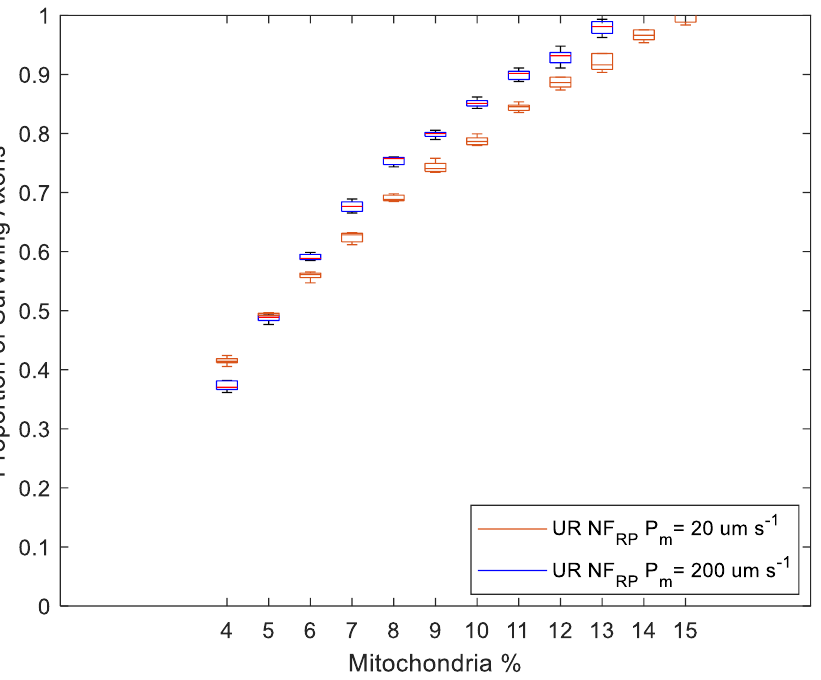
Figure 9. Axonal survival increases proportionally with the mitochondrial volume ratio (mito%) when the H 2 O 2 production rate in the Stress state is lower than in the Healthy state (NF RP ). Mito% varied between 4 and 20%. Myelinated region models experienced no loss. Simulations using unmyelinated and myelinated models were performed with the same biochemical parameters. In unmyelinated regions, the higher energy needs imposed by less efficient axonal conduction led to higher H 2 O 2 production rates. For unmyelinated models, even if H 2 O 2 production was reduced in the Stress state (NF RP ), axonal degeneration occurred across a wide range of mito% values (4% to 15%) (Figure 9). However, axonal survival increased linearly with mito% (Figure 9). Simulations where production in the Stress state stayed the same or increased (PF RP ) had greater variability in axonal survival than the NF RP simulations for the same mito% (Figures 9 and 10). For the PF RP simulations, the proportion of surviving axons graphed against the mito% had a more sigmoid shape. The proportion of surviving axons changes more dramatically for small changes in mito% as the production of H 2 O 2 increases in the Stress state (Figures 10a,b). At the higher membrane permeability value (P m = 200 µm s −1 ) and for the case when production in the Stress state increases, there were abrupt changes in survival for small variations in mito% around the 10% mito% value (Figure 10b). In this case, slight topological changes resulting from re-running the axonal placement algorithm for each run result in greatly different axonal survival ratios. The sensitivity of results to small axonal placement changes suggests that the interplay between axonal topology, membrane permeability and mito% are relevant to oxidative injury to axons. Membrane permeability increases oxidative linkage between adjacent axons. Surpris- ingly, higher membrane permeability increases axonal losses at lower mito% and de- creases axonal loss at higher mito% (Figure 9 and 10). This was true for both Stress state production models. Specifically, in the NF RP production model, a higher membrane per- meability decreases axonal loss when mito% > 5% (Figure 9), in the Stress = Health model when mito > 7% (Figure 10a), and in the PF RP model when mito% > 10% (Figure 10b). The existence of a mito% value below which high membrane permeability is a deleterious fac- tor in axonal survival and above which membrane permeability has a positive effect demonstrates that the many factors which contribute to the subcellular oxidative